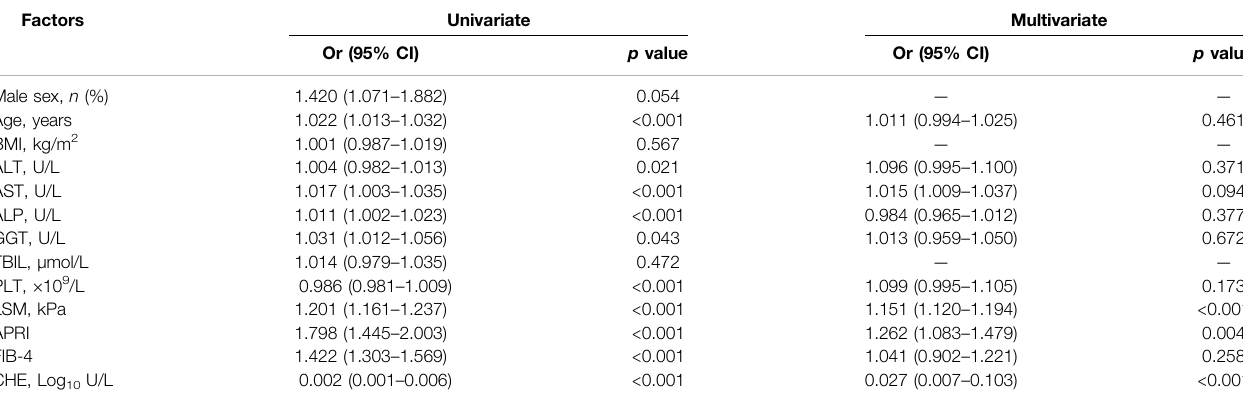
TABLE 2 | Univariate and multivariate analyses for factors associating with signi fi cant fi brosis in chronic DILI patients.